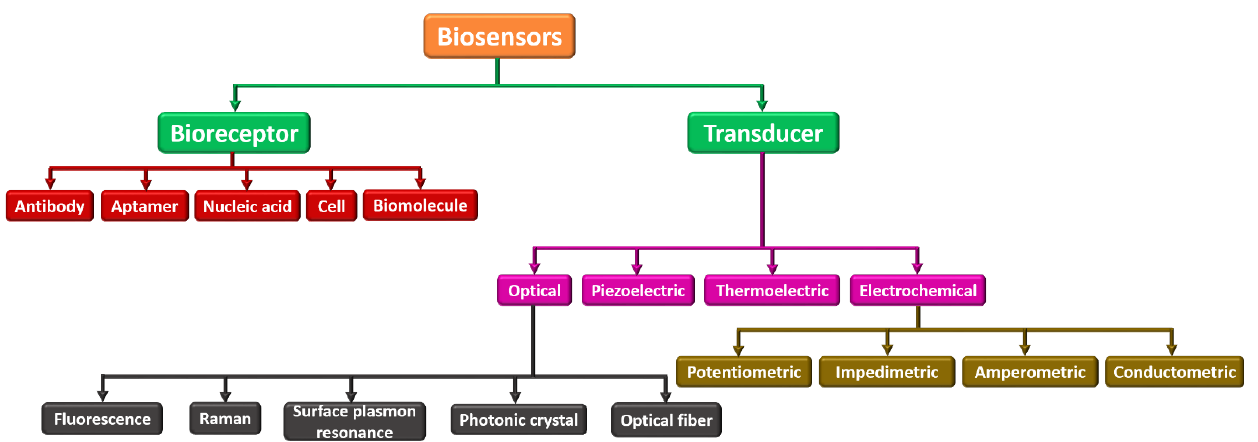
Figure 4. Classification of various biosensors based on their bioreceptor element and transducing component.